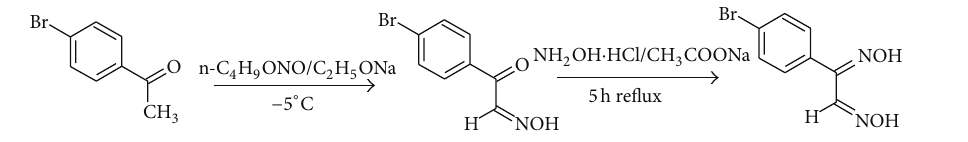
Figure 1: Schema of the synthesis of the ligand. Table 1: TGA data and electronic parameters of ligand and its complexes.